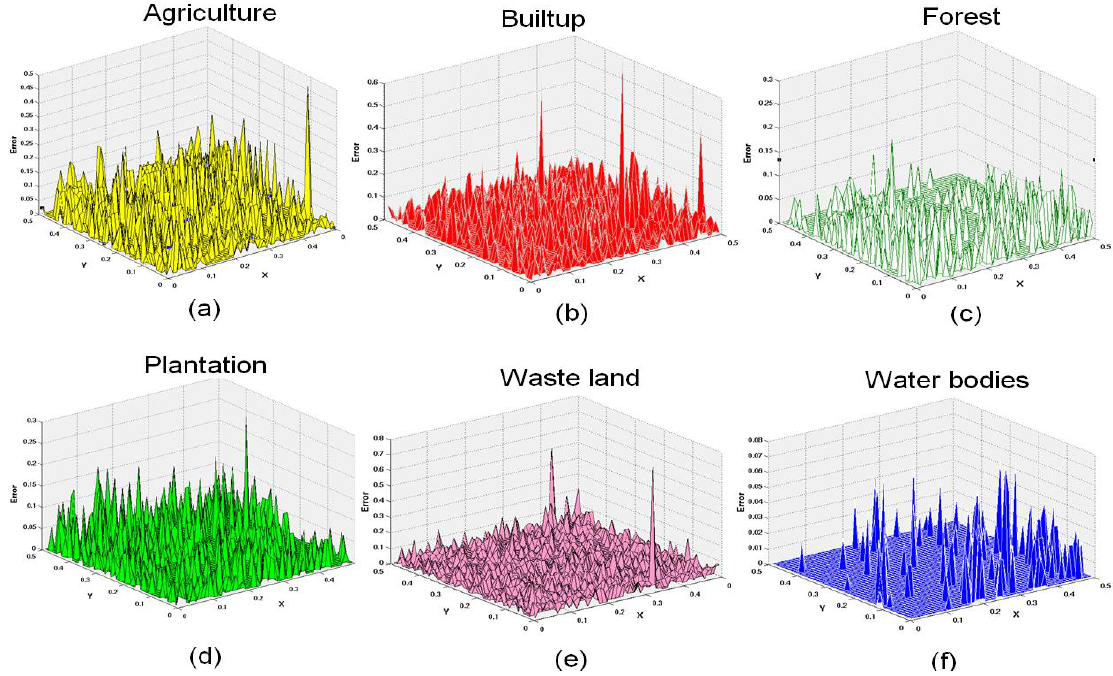
Figure 14. Error distribution of MODIS abundance obtained from LMM (X and Y axes are the two dimensions in feature space and Z axis is the absolute difference between real/reference and estimated class proportion) for the six